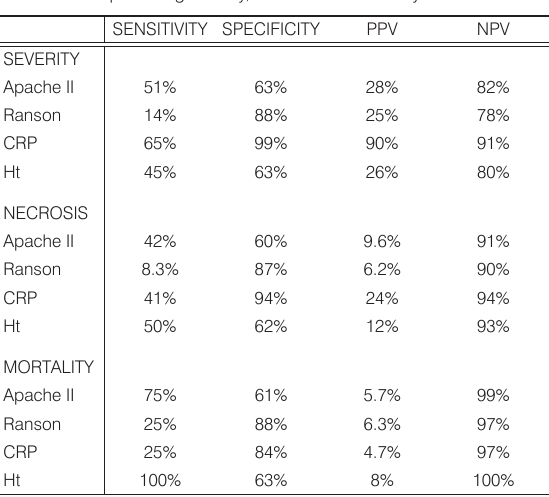
Table 5. Univariate analysis regarding